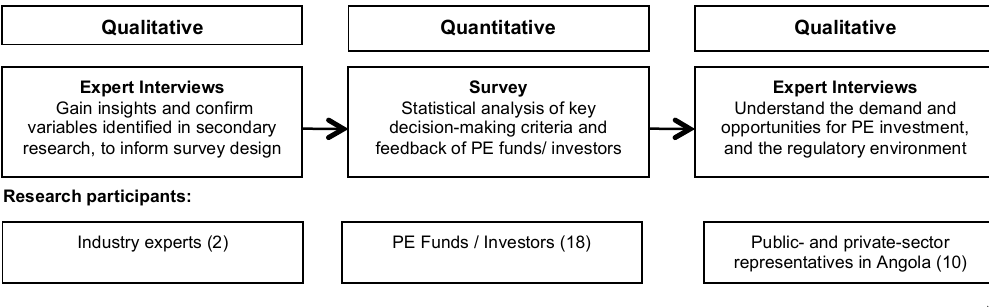
Methodological overview (number of participants in